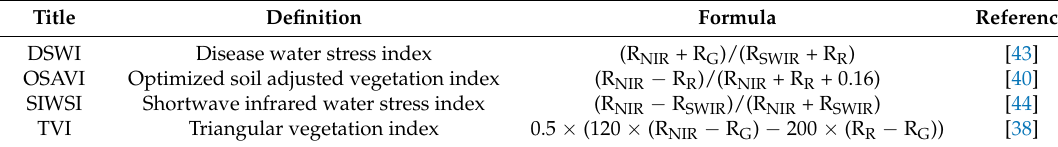
Table 3. Summary of the spectral vegetation indices used for monitoring of powdery mildew, with